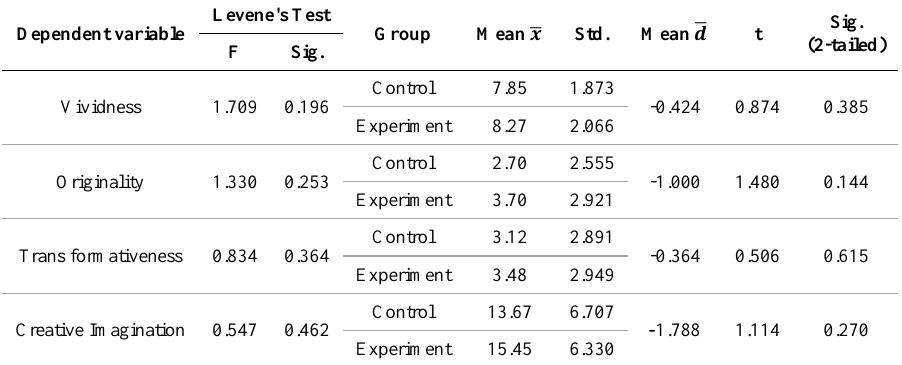
Table 5. Average creative imagination scores before learning by the experimental and control groups